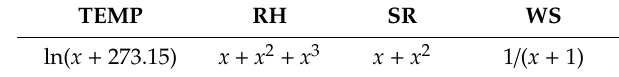
Table 7. Angles used for rotation of angular wind direction at different sites.